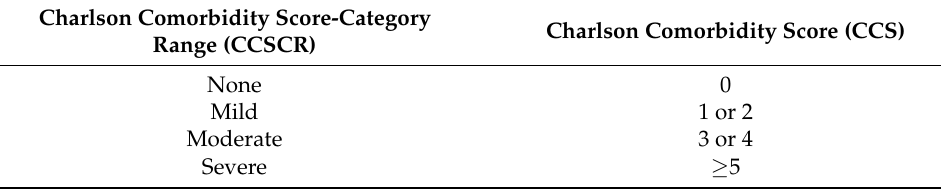
Table 2. Summary of Charlson Comorbidity Score-Category Range